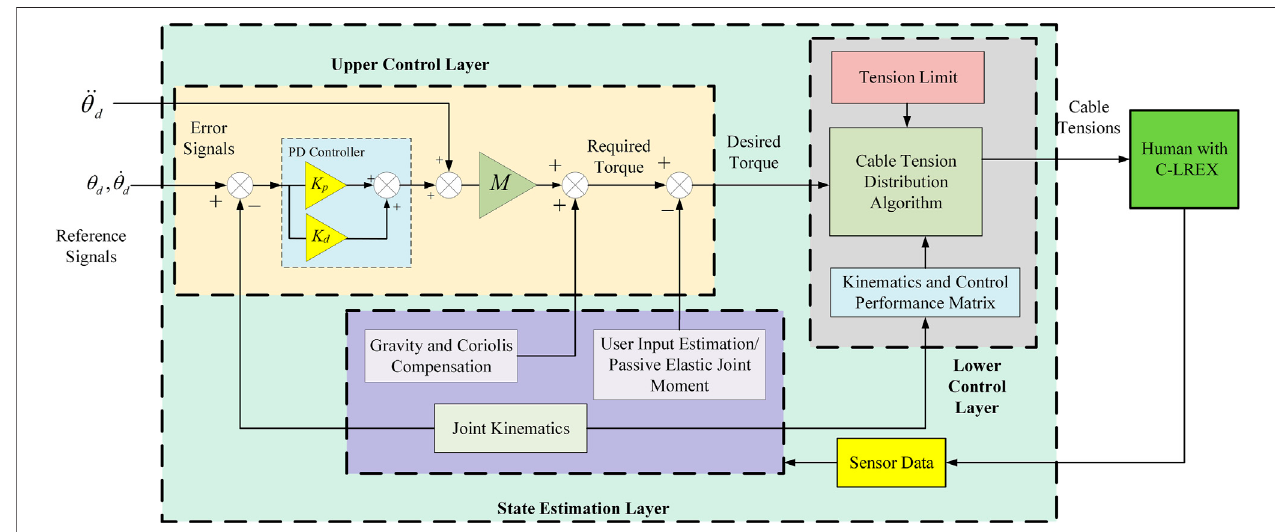
FIGURE 2 | Generalized control